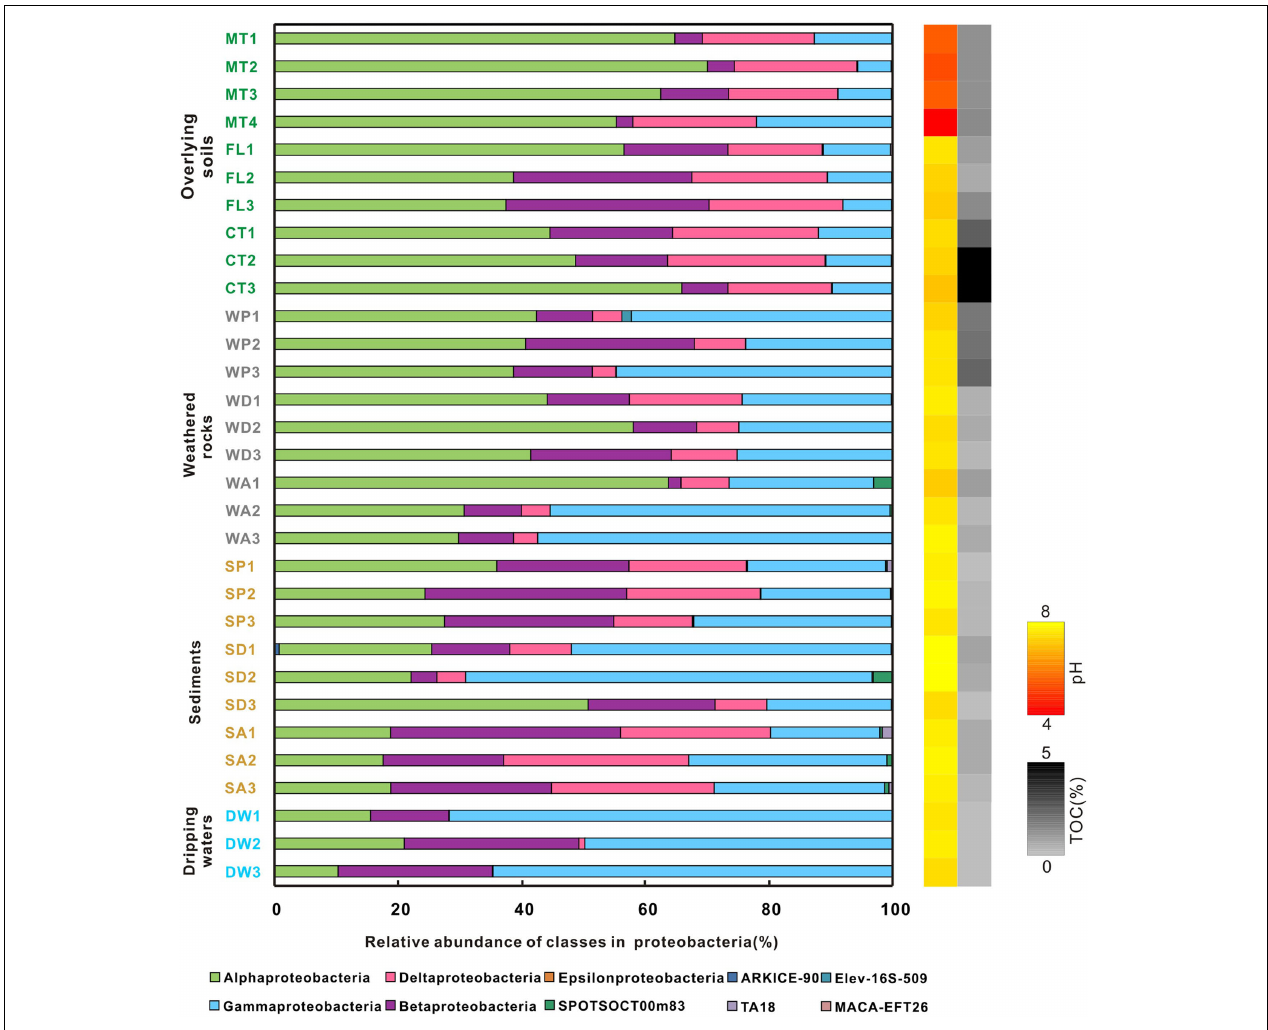
FIGURE 3 | Relative abundance of proteobacterial class from different habitats at Heshang Cave. Different colors denote samples of overlying soil (green), weathered rock (gray), sediment (brown), and dripping water (blue). The pH and TOC for each sample are shown on the right, using a similar scheme as Figure 2 . Abbreviations are the same as described for Figure 1